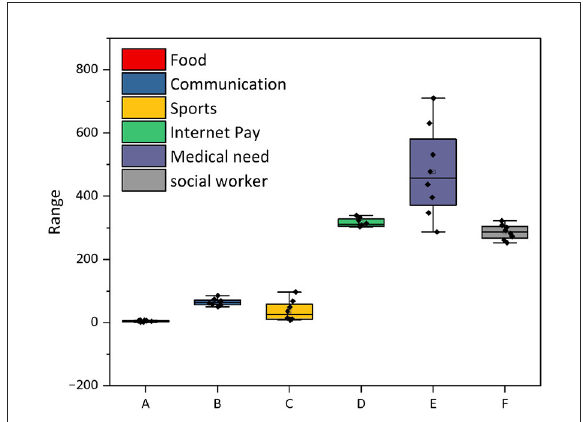
FIGURE9 Baseline indicators of efficiency in addressing adaptation issues before and after government